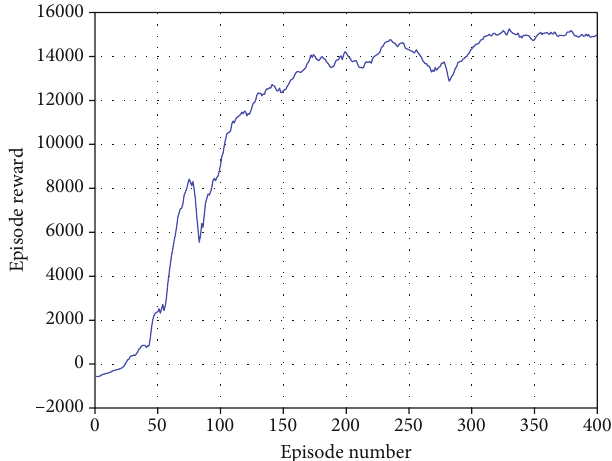
Figure 4: The learning process of TD3 agent under ideal guide TD3 to conduct policy search. Figure 3 describes the structure of PID-Guide TD3.